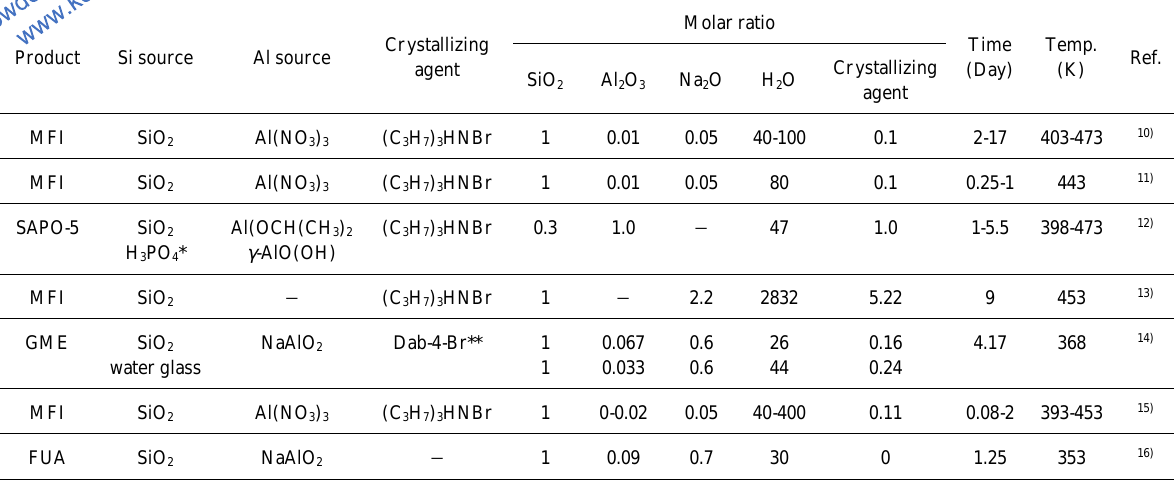
Table 3 Hydrothermal conditions for Zeolite membrane